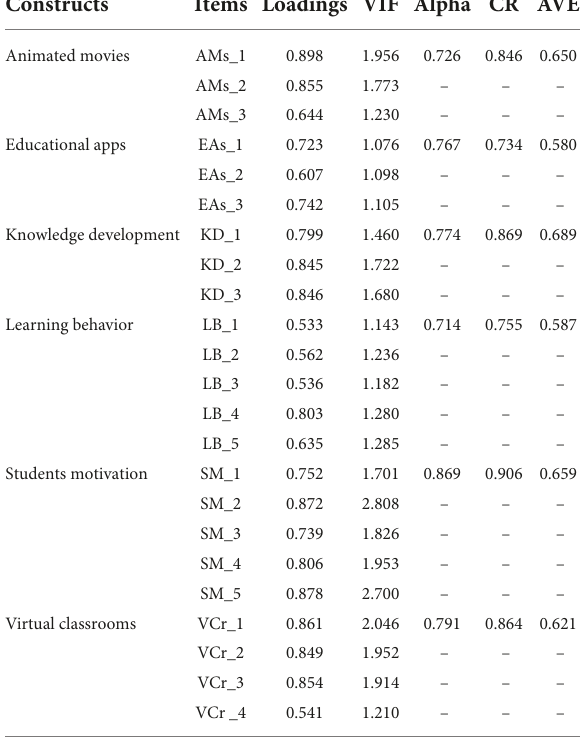
TABLE 2 Reflective indicator loadings, internal consistency reliability, and convergent validity.